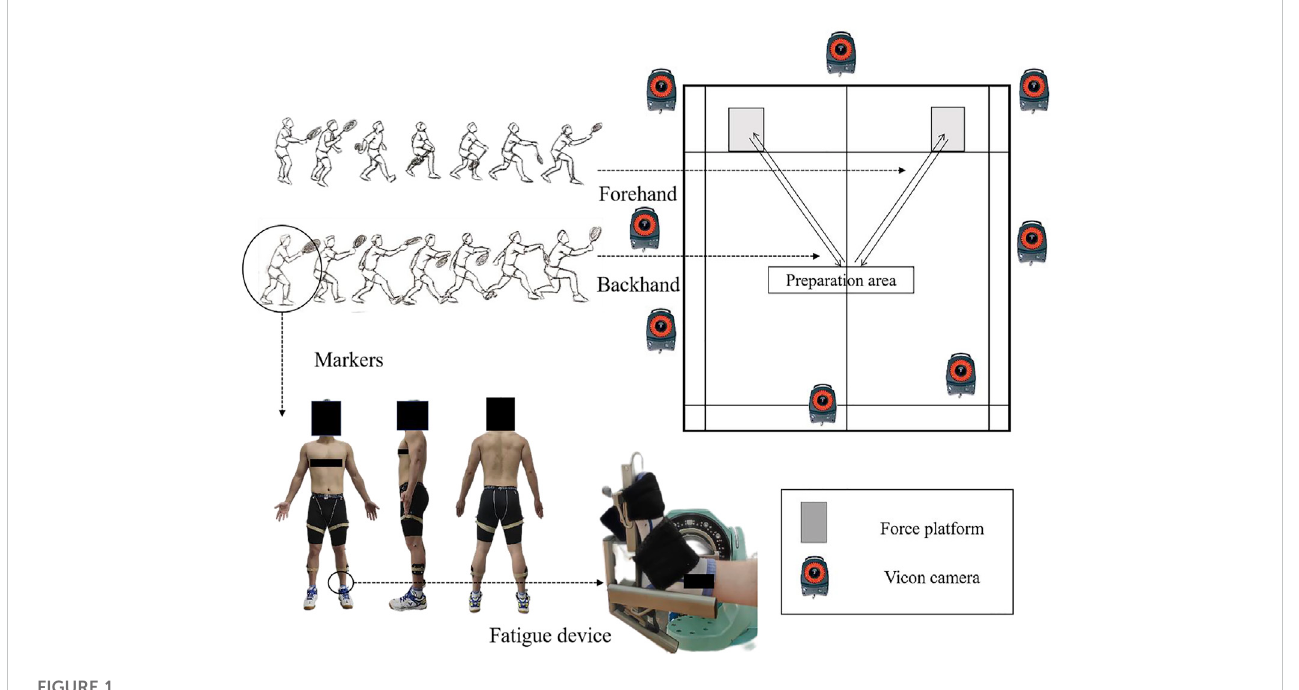
FIGURE 1 Illustration of experimental con fi guration and fatigue